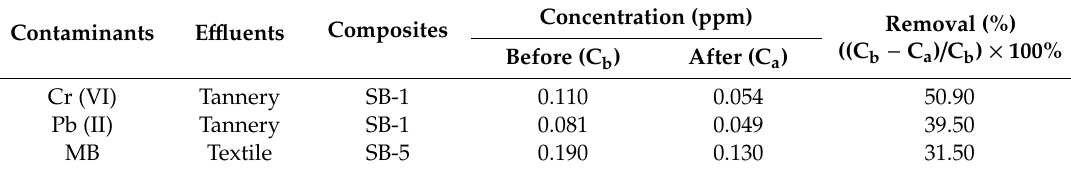
Table 3. Removal % of heavy metals and dye from tannery and textile e ffl uents.